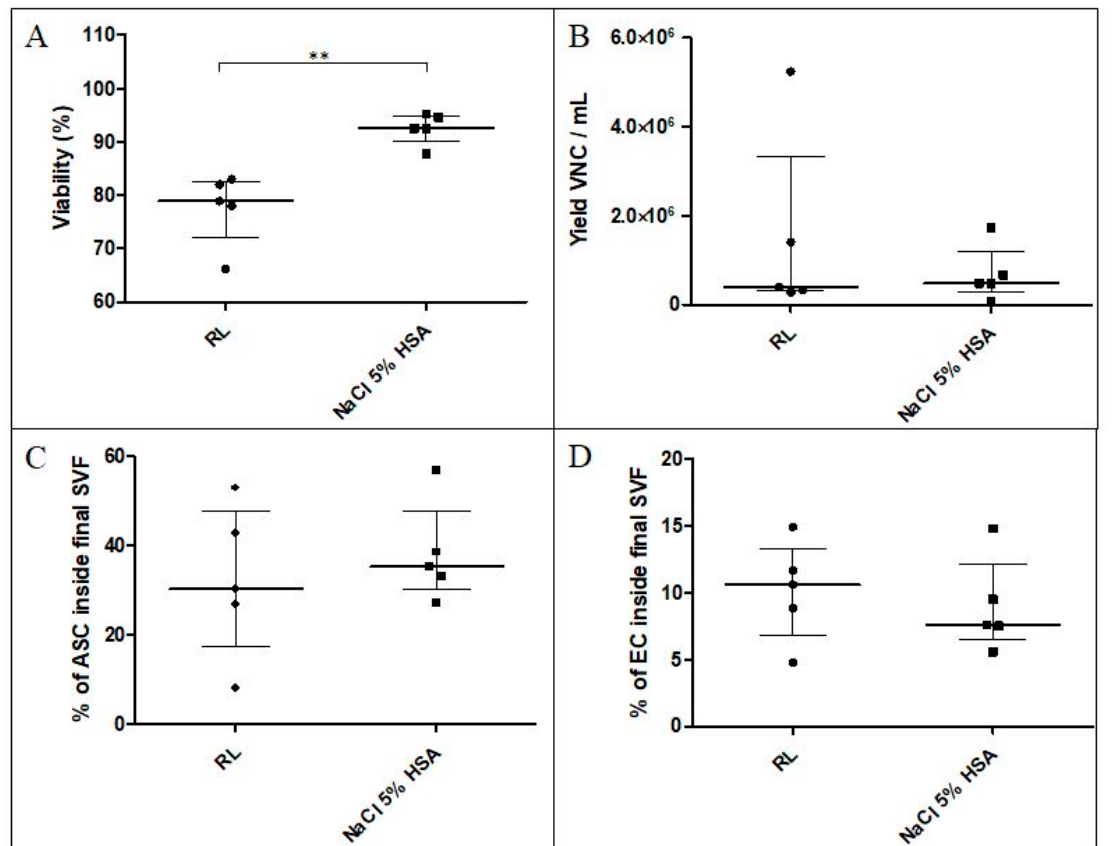
Figure 3. A ssessment of two different solutions for filtration, washing, and final resuspension of SVF. The solutions tested were RL and NaCl 5% HSA. ( A ) Viability was statistically higher for the NaCl 5% HSA group ( p = 0.01). ( B ) Yield of VNCs per mL AT, ( C ) percentage of MSCs, and ( D ) ECs were not statistically di ff erent. RL: Ringer’s lactate; NaCl 5% HSA: saline solution enriched with HAS; VNCs: viable nucleated cells; MSCs: mesenchymal stem cells; ECs: endothelial cells.**: p =